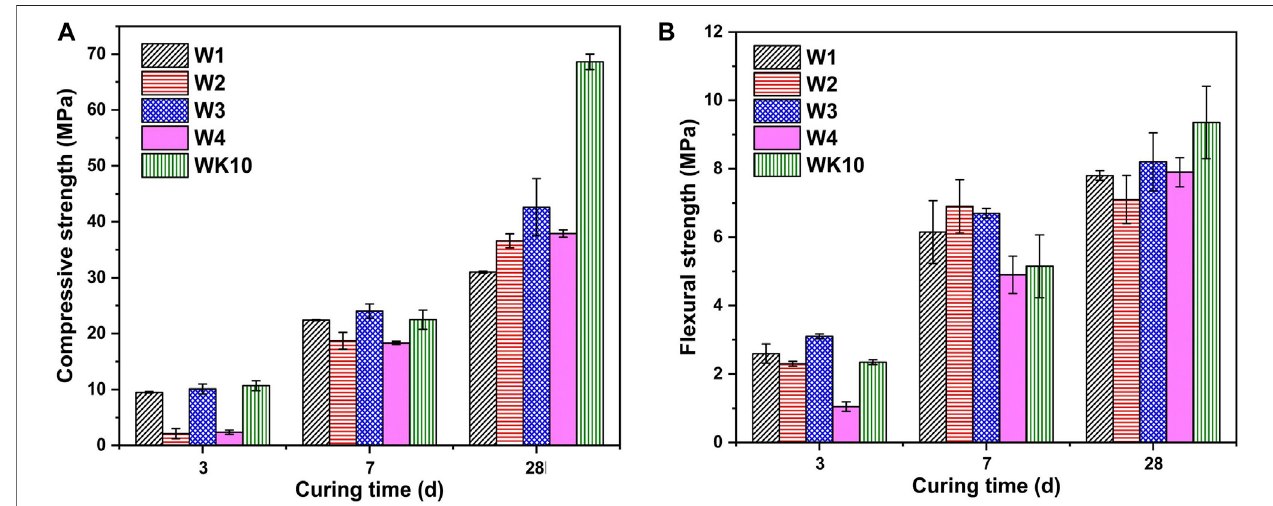
FIGURE 14 | (A) Compressive and (B) fl exural strength development of P-SSC binders.